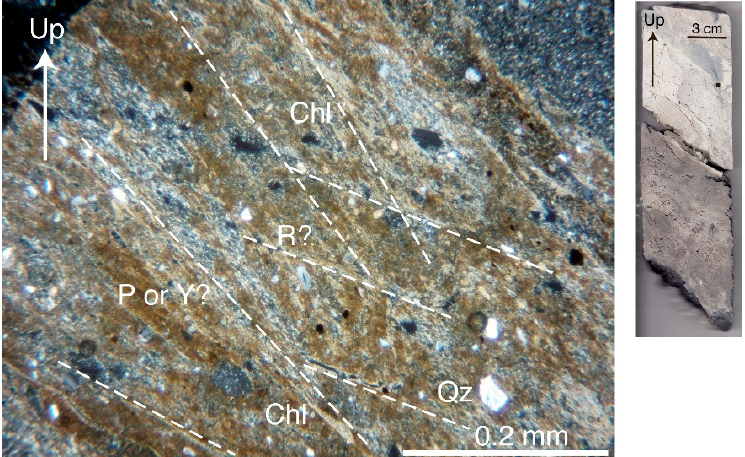
Figure 4. Microstructures in gouge from borehole core sample B4 (crossed polarized light). Dashed lines indicate composite planar structures, along which elongated chlorite detrital grains were aligned. Inset diagram shows the cross-section of borehole core sample B4, the locality for which is indicated in Figure 3b. The dot in the inset diagram shows the locality of the thin section. The up direction of the borehole is shown by arrows. Qz, quartz; Chl, chlorite.